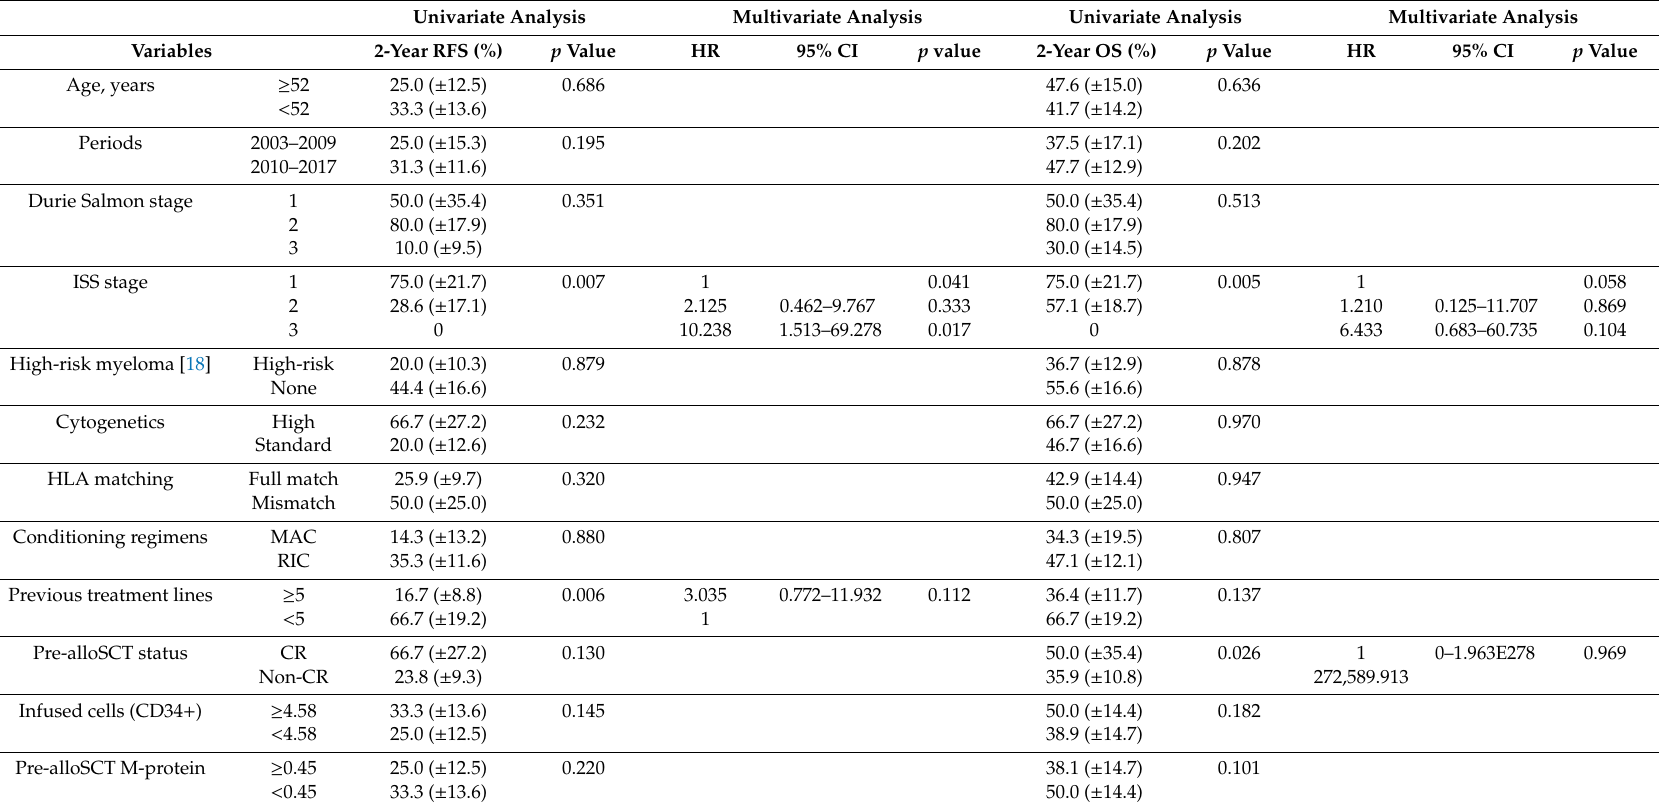
Table 3. The univariate and multivariate analyses for relapse-free survival and overall survival. Univariate Analysis Multivariate Analysis Univariate Analysis Multivariate